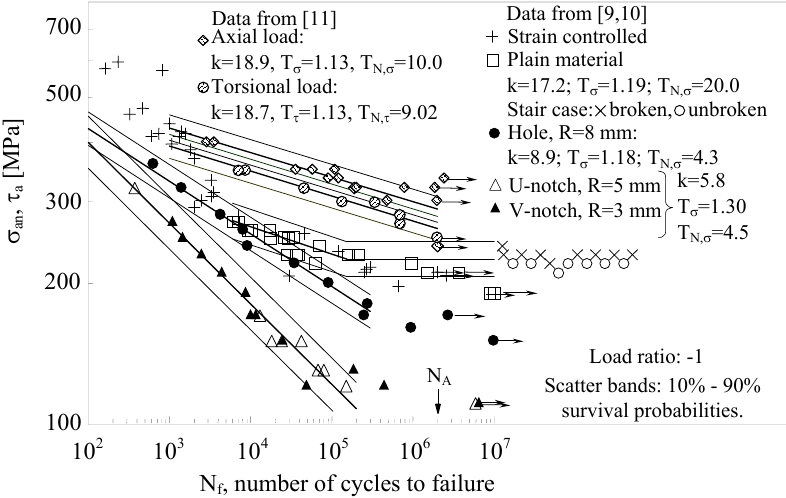
Figure 1: Fatigue data analysed in terms of net-section stress amplitude. Scatter bands are defined for 10% and 90% survival